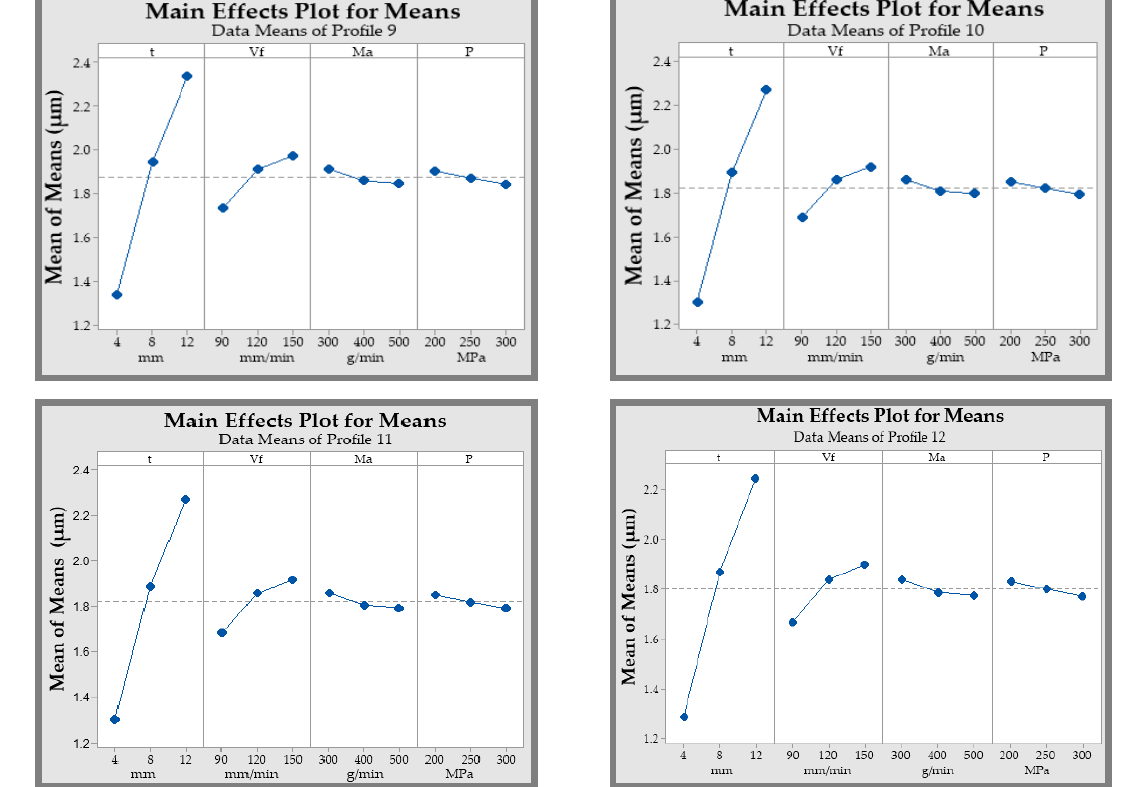
Figure 13. Main effect plot of means of surface roughness against input parameters. Table 10. Optimum parameters for material removal